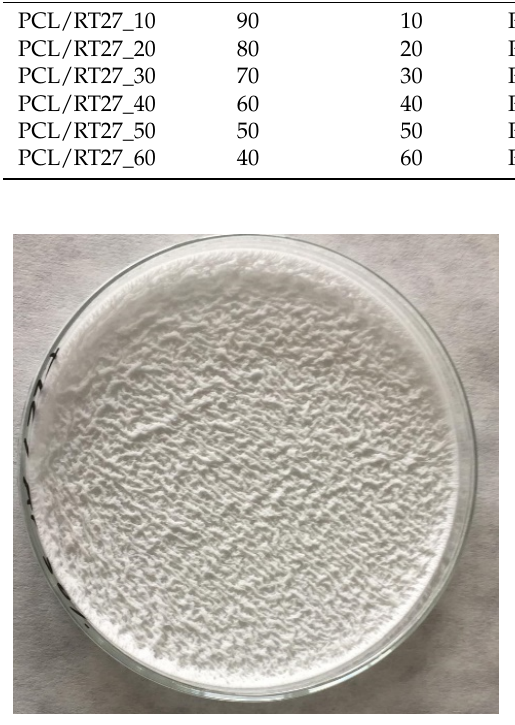
Figure 1. Dried blend of PCL/RT27 60% CSS-PCM.